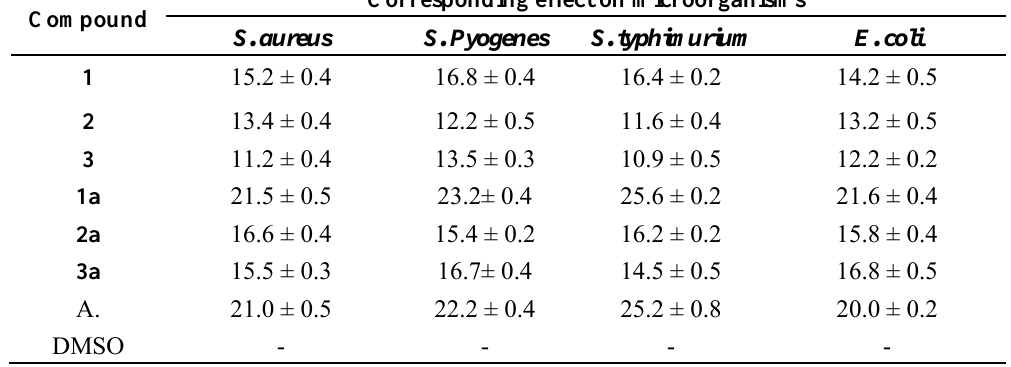
Table 1. Antibacterial activity of steroidal thiosemicarbazones and their complexes, Positive control A (Amoxicillin), and negative control (DMSO). Measured by the Halo Zone Test (unit,